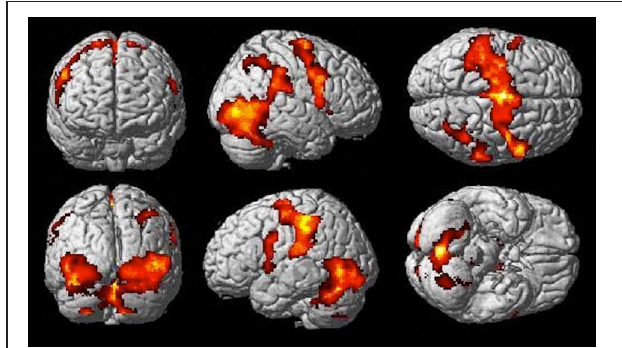
FIGURE 3 | Imitate BOLD contrast ( p < 0 . 05